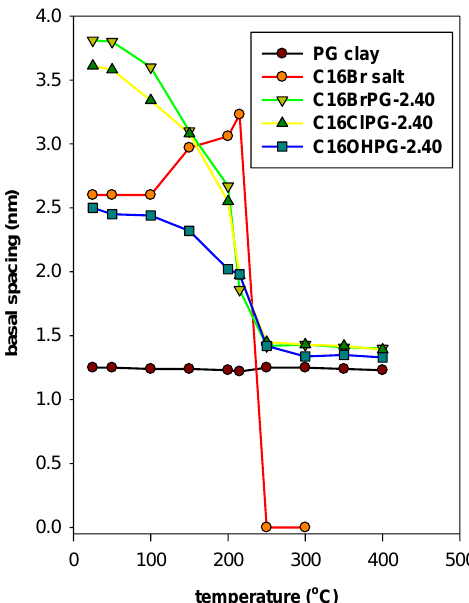
Figure 12. The variation of basal spacing (d 001 ) of different materials with preheated treatment